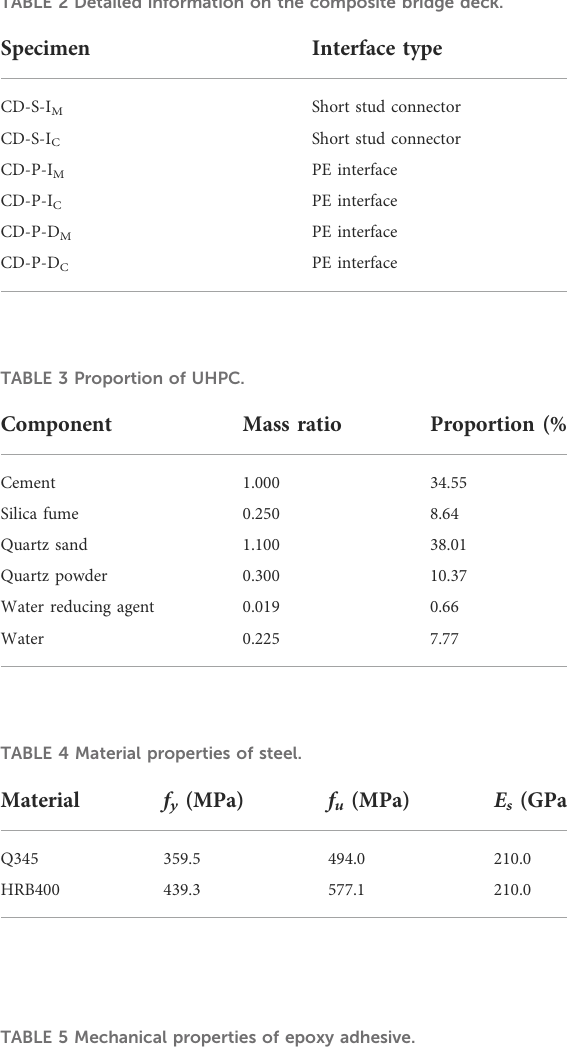
TABLE 2 Detailed information on the composite bridge deck.